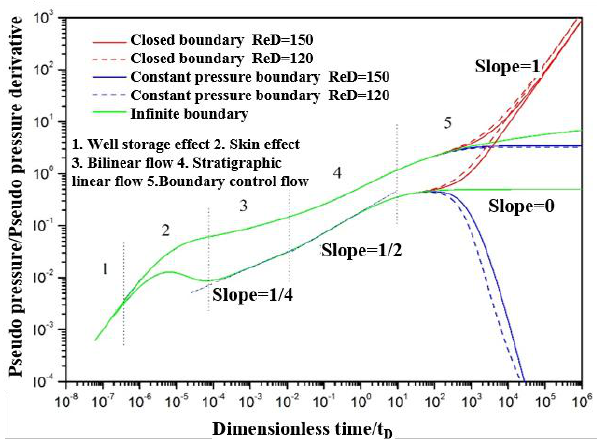
Figure 2—Typical curves of fractured vertical well.